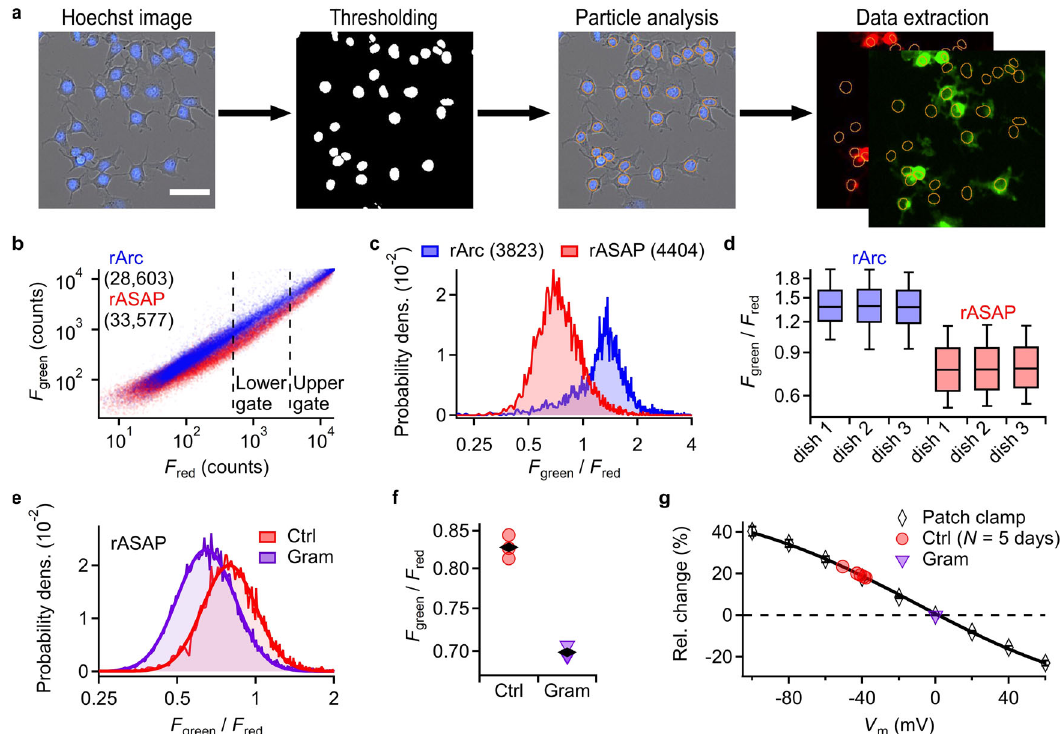
Fig. 2 Automated high-content assay. a Work fl ow for automated extraction of fl uorescence information from images of plated HEK293T cells expressing ratiometric GEVIs; cells were pretreated with the DNA-binding dye Hoechst 33342 enabling automated ROI (orange circles) generation by setting a fl uorescent threshold and applying a particle analysis algorithm on the F F blue channel. blue and transmission light images are superimposed. Scale bar, 50 µ m. For details see methods. b F green as a function of F red of >28,600 individual cells from one cell-culture dish transfected with rArc or rASAP expression vectors, extracted with the method described in a . Dashed lines indicate lower and upper gates used for subsequent data analysis. c Probability density of fl uorescence ratio ( F green / F red ) of gated data from ( b ). d Boxplots of F green / F red values from three separate culture dishes of HEK293T cells expressing rArc or rASAP. e F green / F red distribution of cells from independent cell-culture dishes expressing rASAP with (purple) or without (red) the ionophore gramicidin (1 μ M). The log( F green / F red ) distributions were fi t with Gaussian functions (solid curves, Eq. 4). f Median F green / F red values from three separate cell-culture dishes (as in ( e )). Black rhombi are mean values of the median F green / F red values from individual dishes. g Normalized F green / F red ( V m ) of rASAP with superimposed Boltzmann-type functions (Eq. 1) (from Fig. 1f); parameters of the fi t were R max = 0.56, Δ r = − 178.6%, V half = − 11.5 mV, k = 54.0 mV. Average V F F F F s m of HEK293T cells (red) was estimated by normalization of green / red of untreated cells to green / red of gramicidin-treated cells, assuming full depolarization to 0 mV by gramicidin. Each data point is the average of 3 individual measurements (as in ( e , f distribution of F green / F red, was 1% for rASAP (Fig. 2e), i.e. smaller than the symbol size in Fig. 2f. To estimate the dish-to-dish dent days with three dishes each and achieved an average stan- dard deviation of the median F green / F red from dish to dish of 1.8 ± 0.3%.